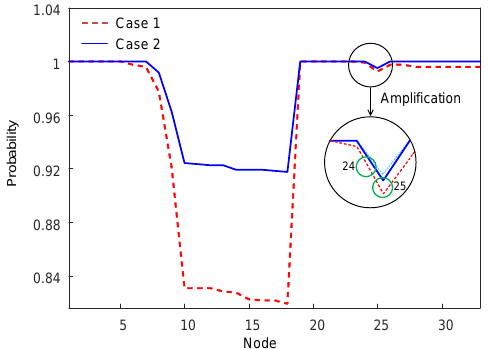
Figure 10. P( |∆ U o | < δ o ) at each node in a day. Figure 10. P(| ∆ U o | < δ o ) at each node in a day.